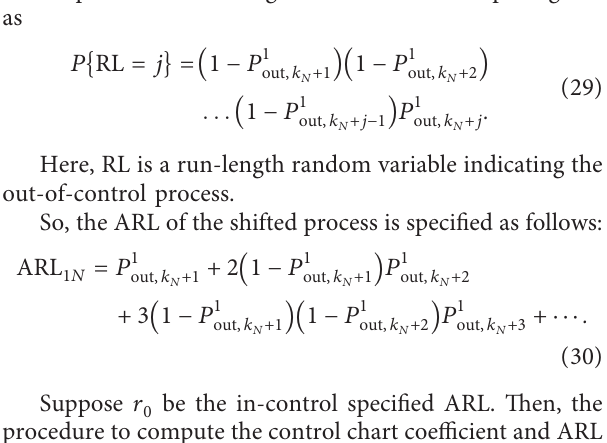
Table 1: The values of NARL when a � 1 . 95 and 2 . 05 and k � 3 and